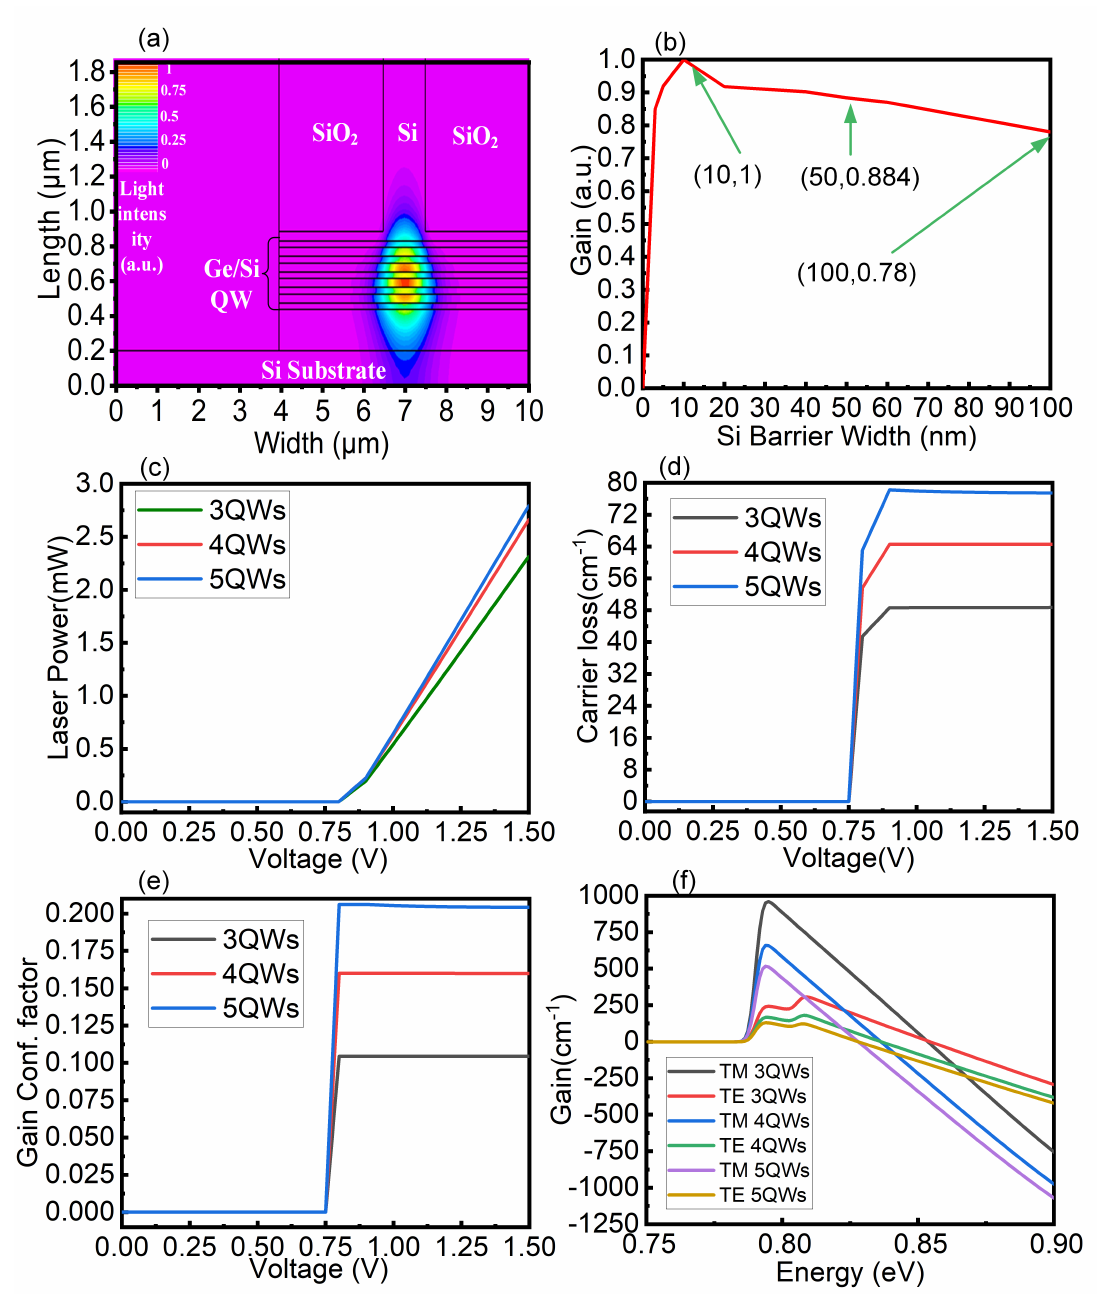
Figure 5. ( a ) Five Ge/Si QWs light field diagrams. ( b ) Normalized gain with different Si barrier widths. ( c ) Comparison diagram of laser power of different QW numbers. ( d ) Comparison diagram of carrier loss of different QW numbers. ( e ) Comparison diagram of gain confinement factor of different QW numbers. ( f ) Gain spectra of different QW